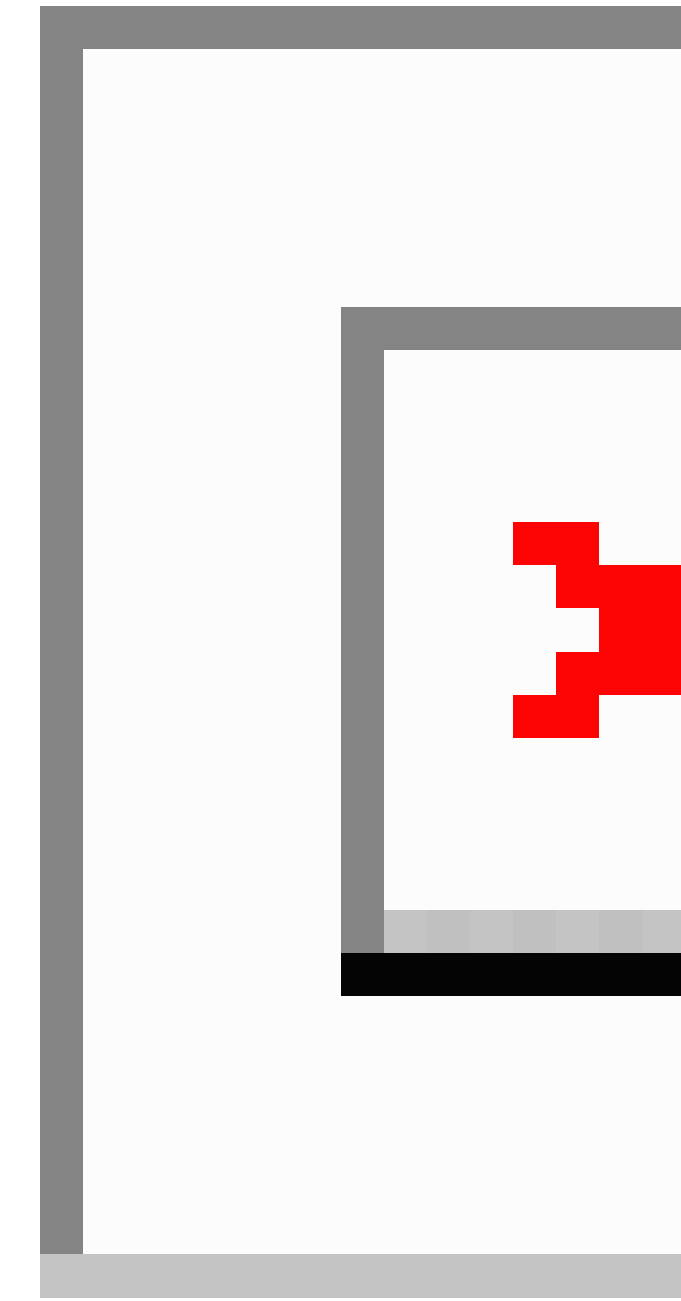
Figure 8. Technical duplicates of post-NEF prescription sets per prescribing